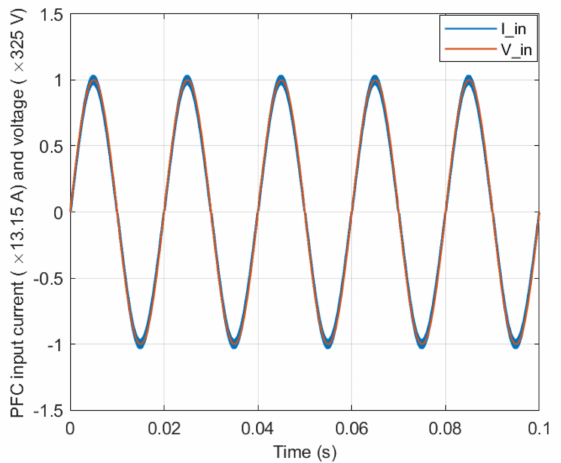
Figure 14. Time series of the voltage (red) and current (blue) drawn from the AC line at the steady- state conditions for the load power of p = 2 kW. Analysis of the PFC controller behavior in the time domain shows that a sinusoidal current setpoint profile is followed with a phase shift less than 2 degrees and limited current